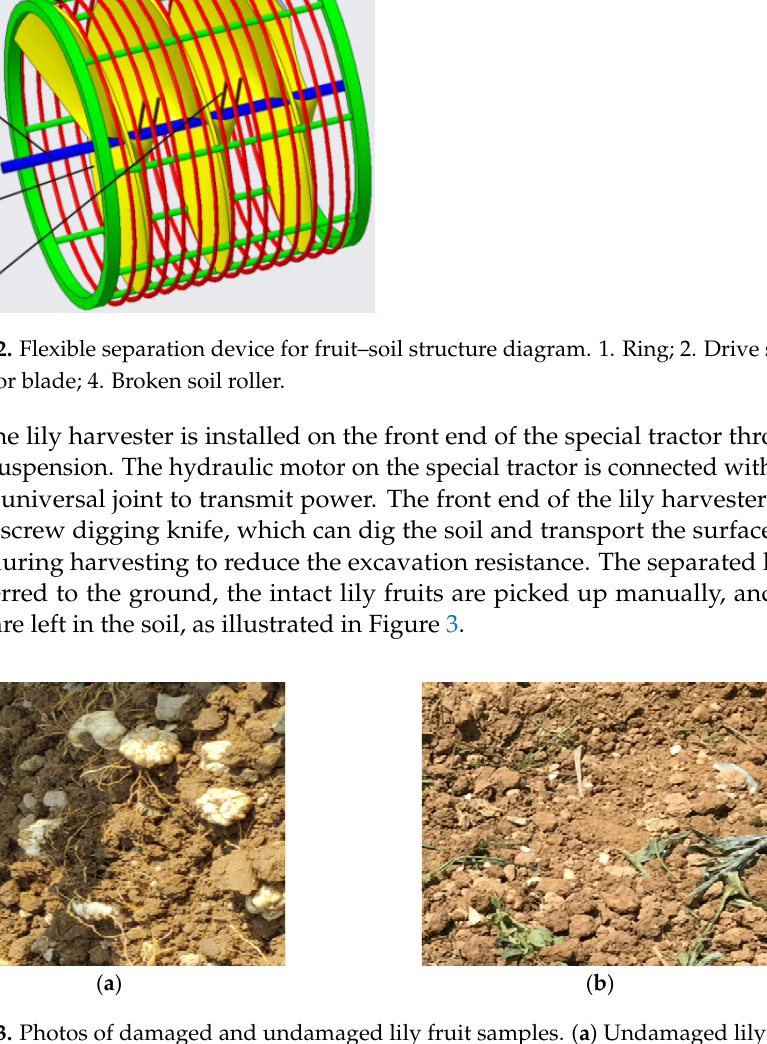
Figure 3. Photos of damaged and undamaged lily fruit samples. ( a ) Undamaged lily fruit samples; ( b ) Damaged lily fruit samples.